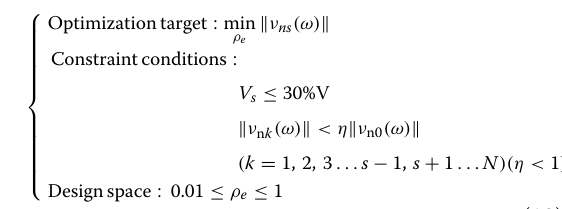
tion of the k th